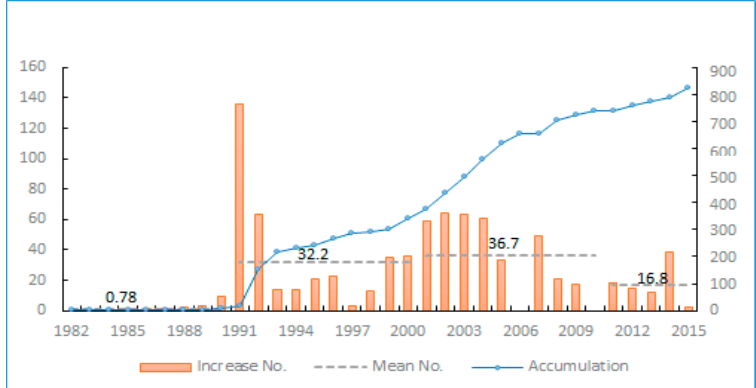
Figure 6. The annual and total numbers of newly approved NFPs in China (1982–2015). (Information collected from the official website of NFGA (http://www.forestry.gov.cn/)).